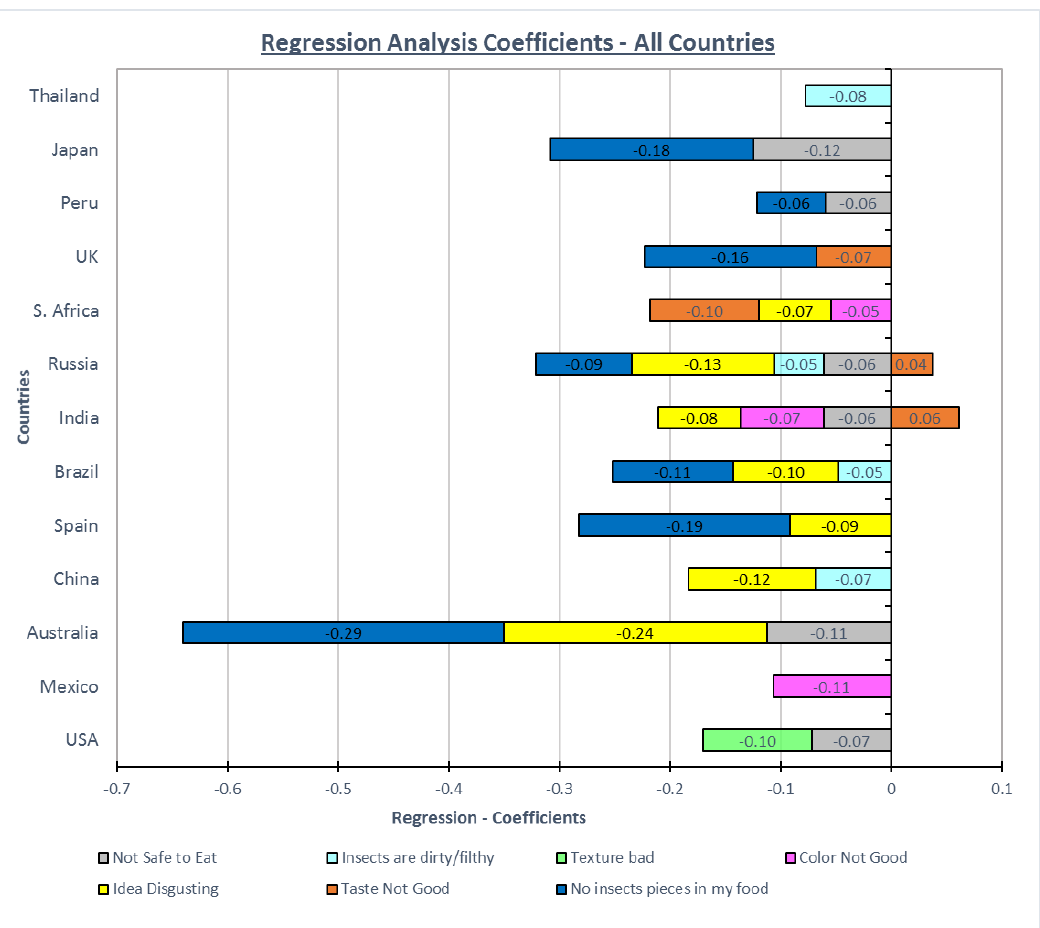
Figure 3. Regression analysis coefficients—the stepwise method .